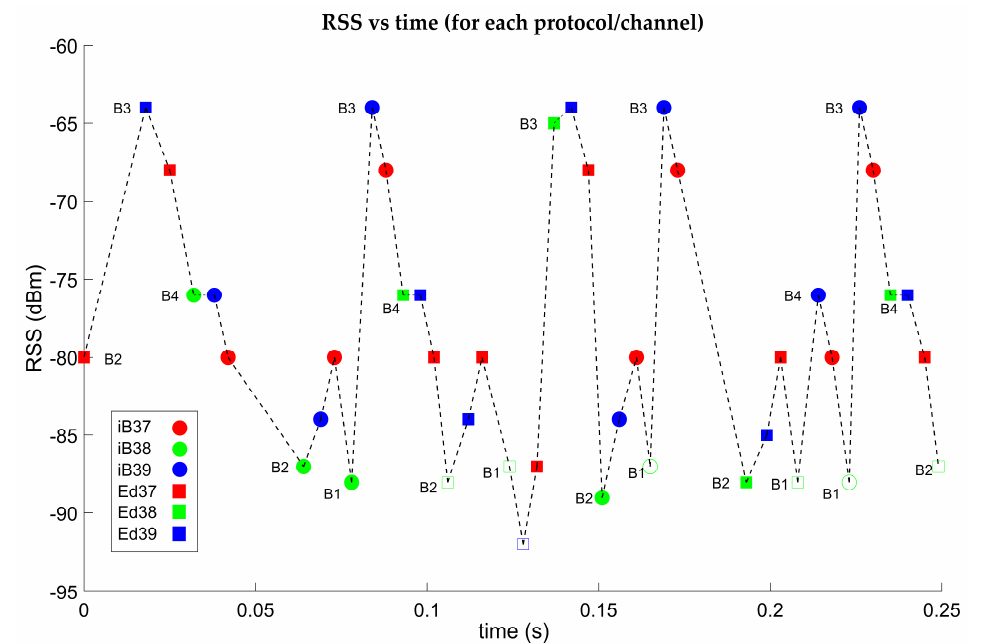
Figure 9. Received signal strength (RSS) values vs. time for each protocol, channel and beacon. Dots represent iBeacon and squares Eddystone protocols respectively.